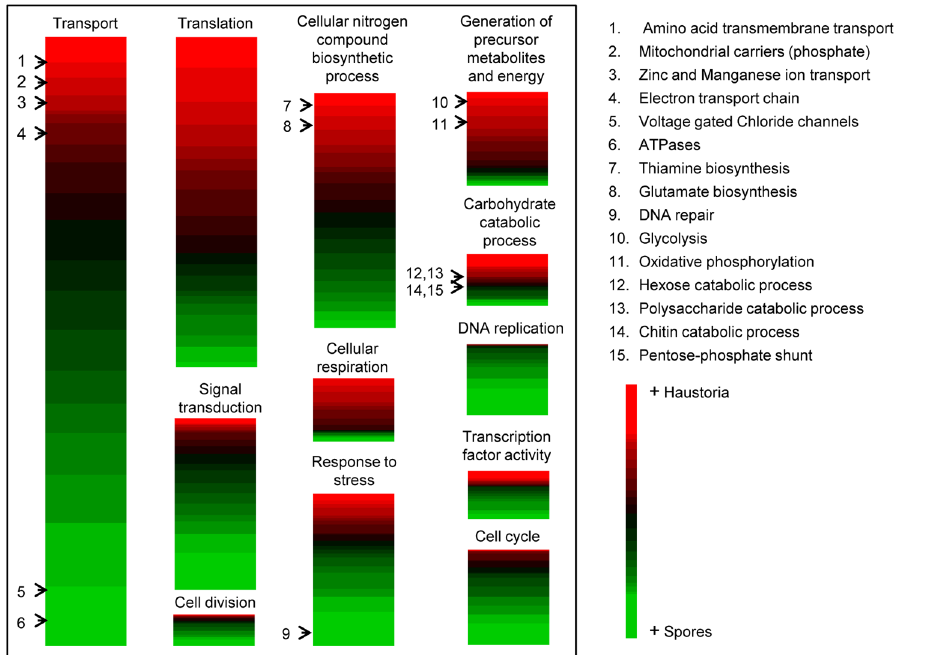
Figure 4. Heatmaps representing relative levels of gene expression classified by metabolic categories. Relevant categories were selected from the B2G analysis. Genes belonging to these categories were listed and organized according to transcript expression values (RPKMs) in haustoria and spores. The colours were based on haustorial expression relative to the overall expression in both tissues; red indicates high expression in haustoria and green, expression in germinated spores. Specific subcategories are shown by the black arrows indicating the presence of specific transcripts discussed in the text.